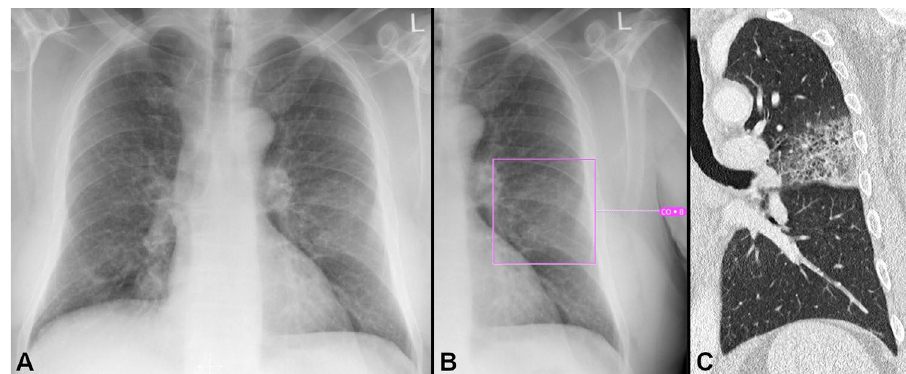
Figure 4. Example of a consolidation detected by the AI Rad Companion Chest X-ray ( A , B ) that was confirmed by a CT scan ( C ): 72 year old, male patient admitted to the hospital with fever, dyspnea and severe cough.